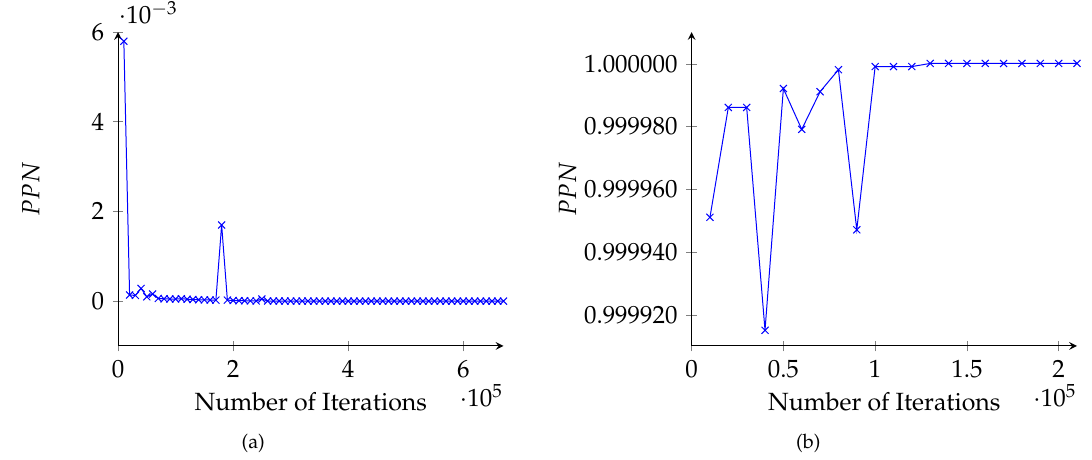
Figure 5. Probability-based proof number (PPN) value of the root of two different positions for PPNS. ( a ) an example position with a time difference of 322.345 s; ( b ) an example position with a time difference of 77.802 s.